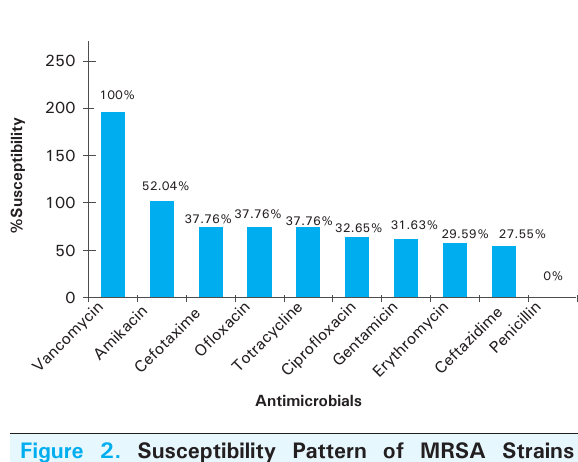
Figure 2. susceptibility Pattern of MrsA strains